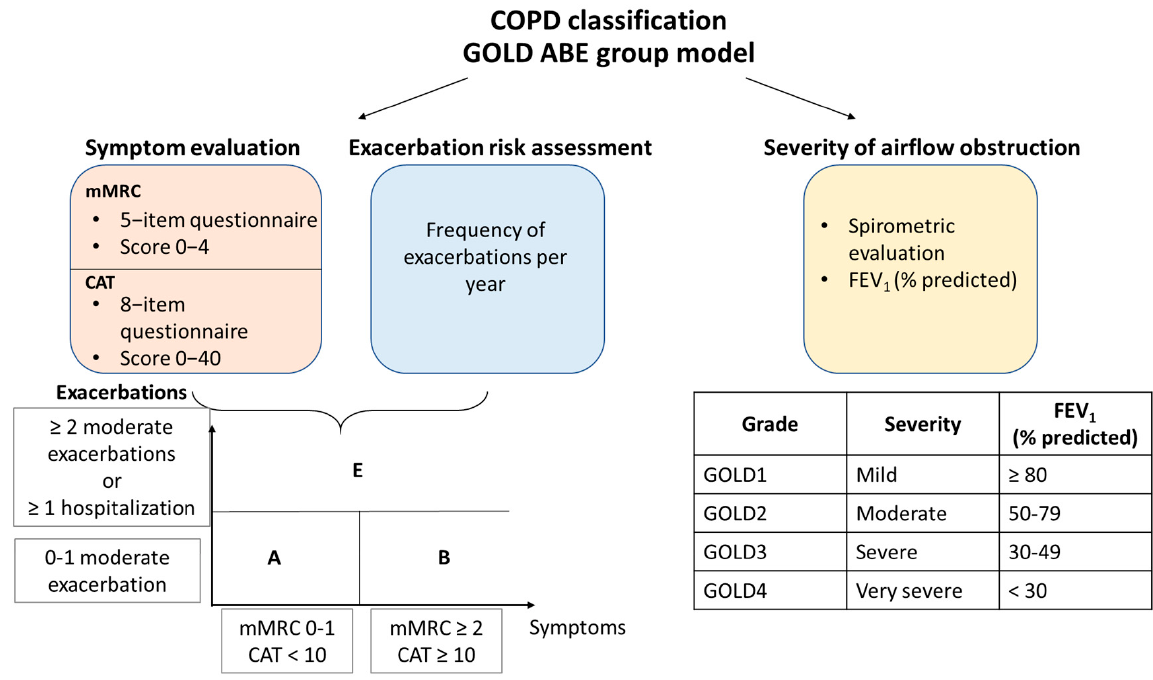
Figure 2. COPD assessment. GOLD ABE group model. Abbreviations: mMRC, the modified Medical Research Council dyspnea scale; CAT, the COPD Assessment Test; FEV 1 , forced expiratory volume in 1 s.